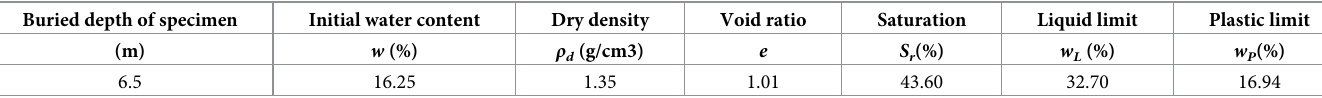
Table 1. Initial physical index of undisturbed loess